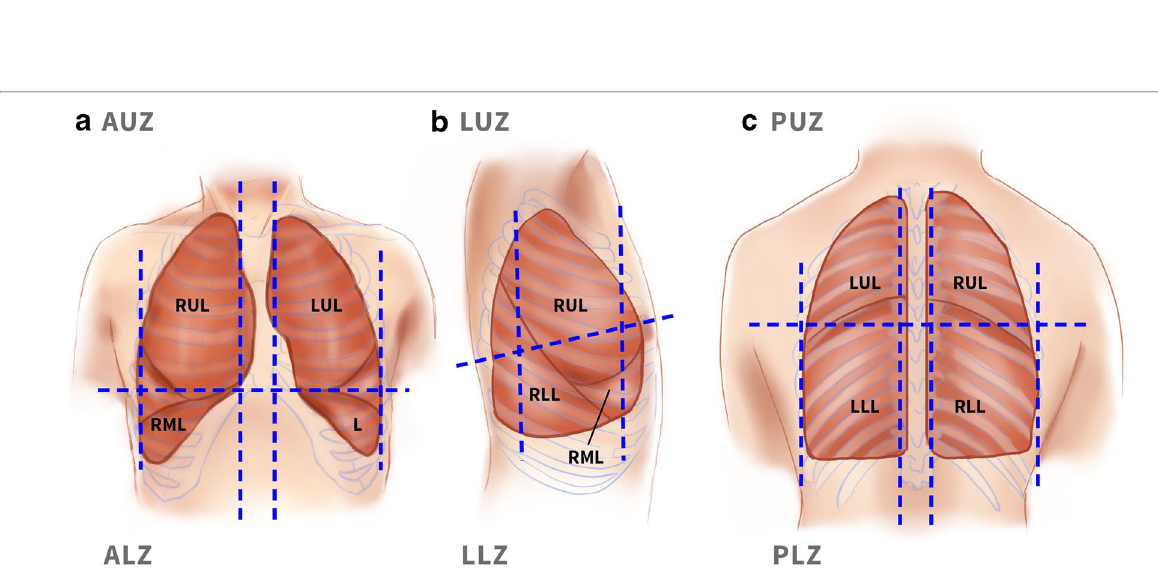
Fig. 5 Surface anatomy of the regions of the lung. Ultrasound surface anatomy: the parasternal, anterior axillary and posterior axillary lines divide the chest wall into anterior, lateral and posterior regions. a The anterior region, delineated superiorly by the clavicle, inferiorly by the liver or the spleen, medially by parasternal line and laterally by the anterior axillary line. The anterior region is further divided by an arbitrary line to anterior upper zone and anterior lower zone. b The lateral region, delineated superiorly by the axilla, inferiorly by the liver or the spleen, anteriorly by the anterior axillary line and posteriorly by the posterior axillary line. An arbitrary line further divides the lateral region to lateral upper zone and lateral lower zone. c The posterior region, delineated by the posterior axillary line laterally and paravertebral line medially. A horizontal arbitrary line at the tip of the scapula further divides the posterior region to upper and lower zone. ALZ anterior lower zone, AUZ anterior upper zone, L lingula, LLL left lower lobe, LLZ left lower zone, LUL left upper lobe, PLZ posterior lower zone, PUZ posterior upper zone, RLL right lower lobe, RML right middle lobe, RUL right upper